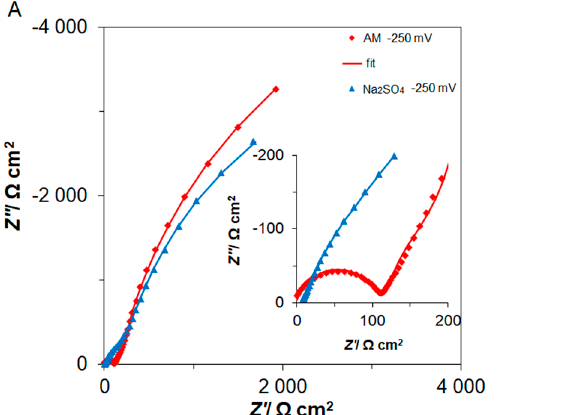
Figure 3. The recorded complex plane Nyquist impedance plots for a graphite electrode in contact with pure Na 2 SO 4 and AM-modified (50 mg dm − 3 ) solution, where ( A ) corresponds to the potential of − 250 mV vs. SCE and ( B ) corresponds to the potential of 150 mV vs. SCE. The solid lines correspond to the data representation according to the equivalent circuit model presented in Figure 4.